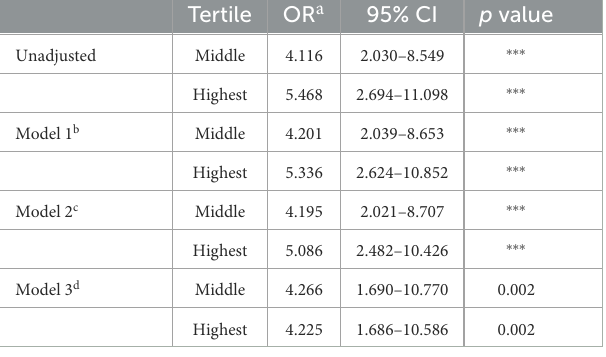
TABLE 5 Multivariate logistic regression analysis demonstrating the independent predictors of depression after